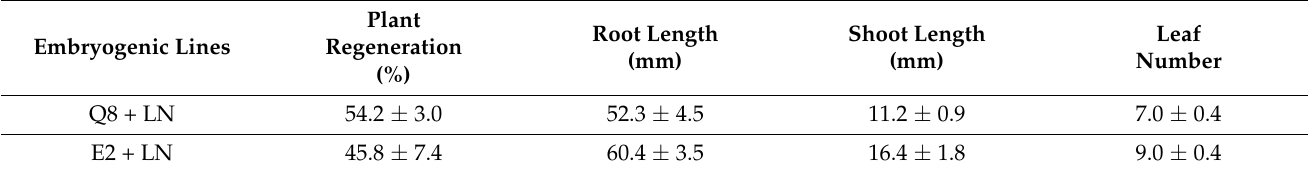
Table 4. Plant regeneration in two different holm oak embryogenic lines after treatment with PVS2 for 15 min, cryostorage for one year in LN and culture on germination medium. Plant Embryogenic Lines